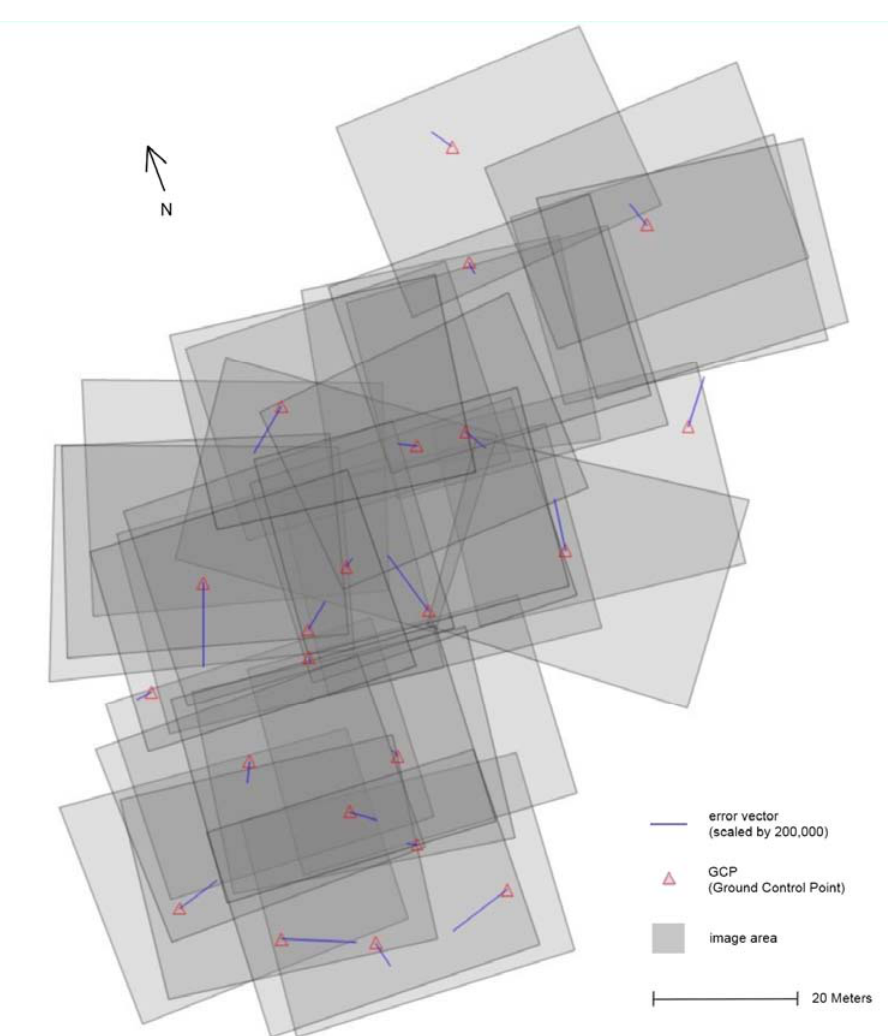
Figure 10. Distribution of GCPs with corresponding residual vectors in no systematic order. GCPs indicated as red rectangles and error vectors indicated as blue lines (image block from study site